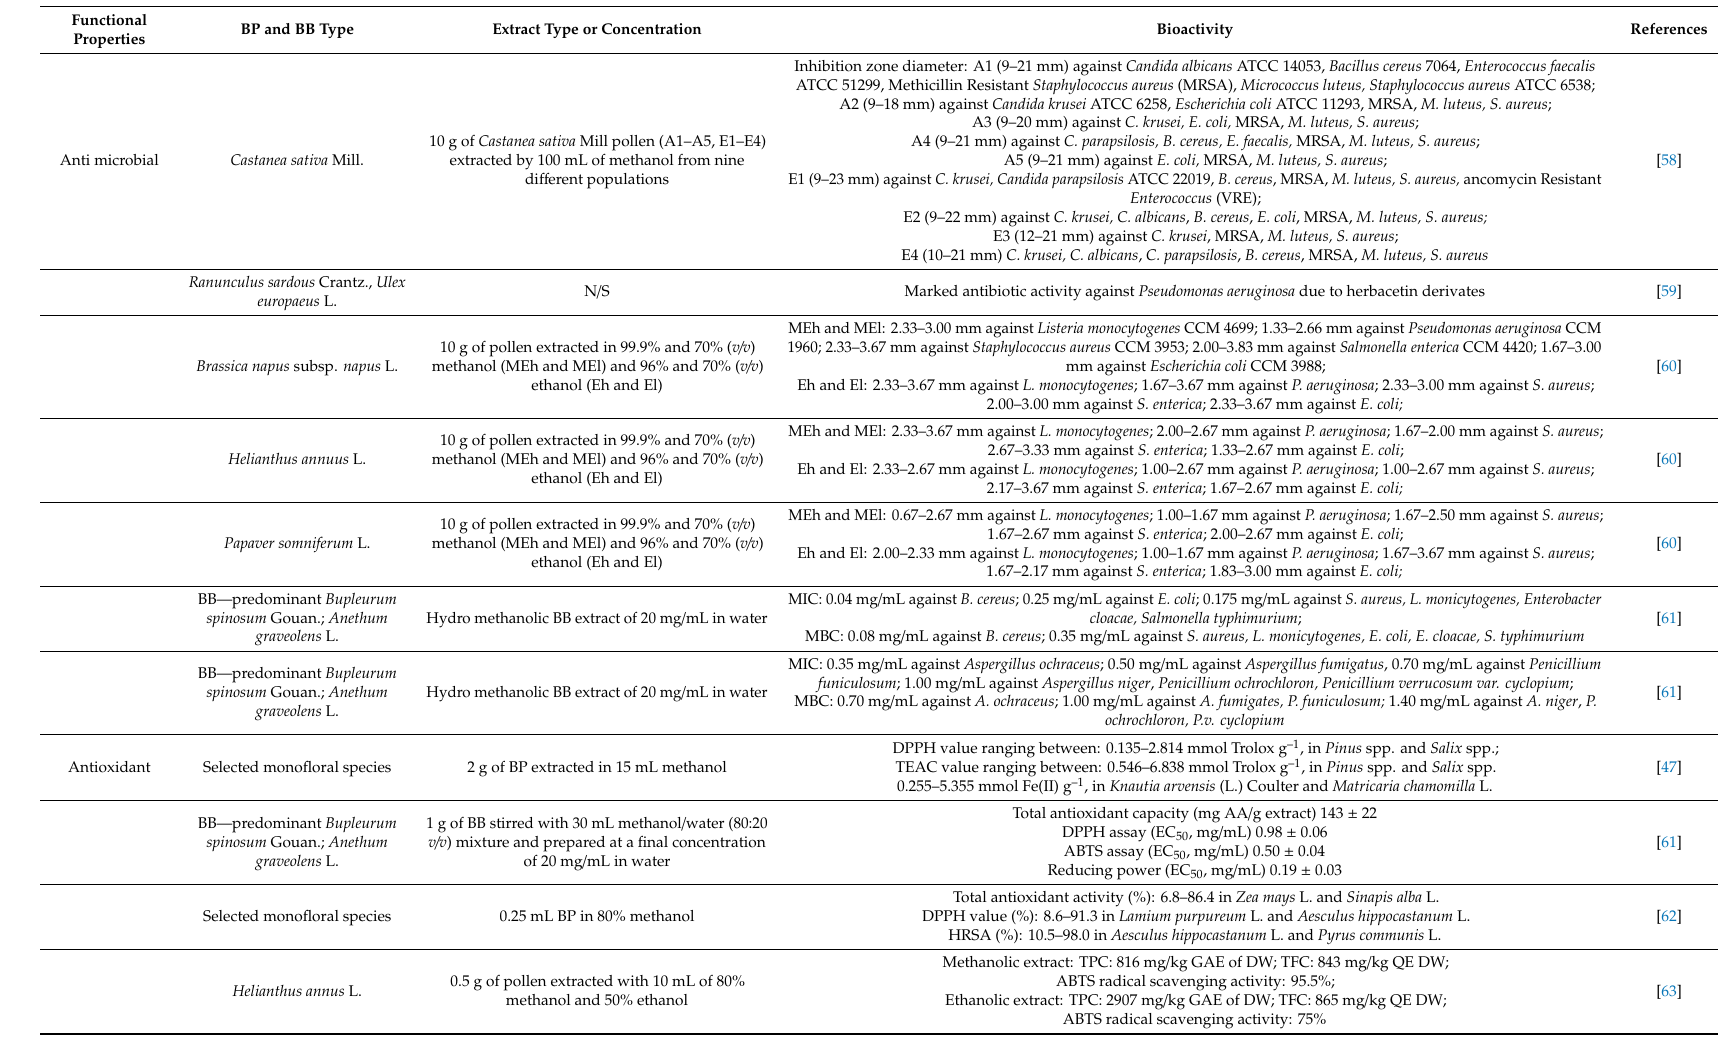
Table 2. Current therapeutic properties of di ff erent bee pollen and bee bread